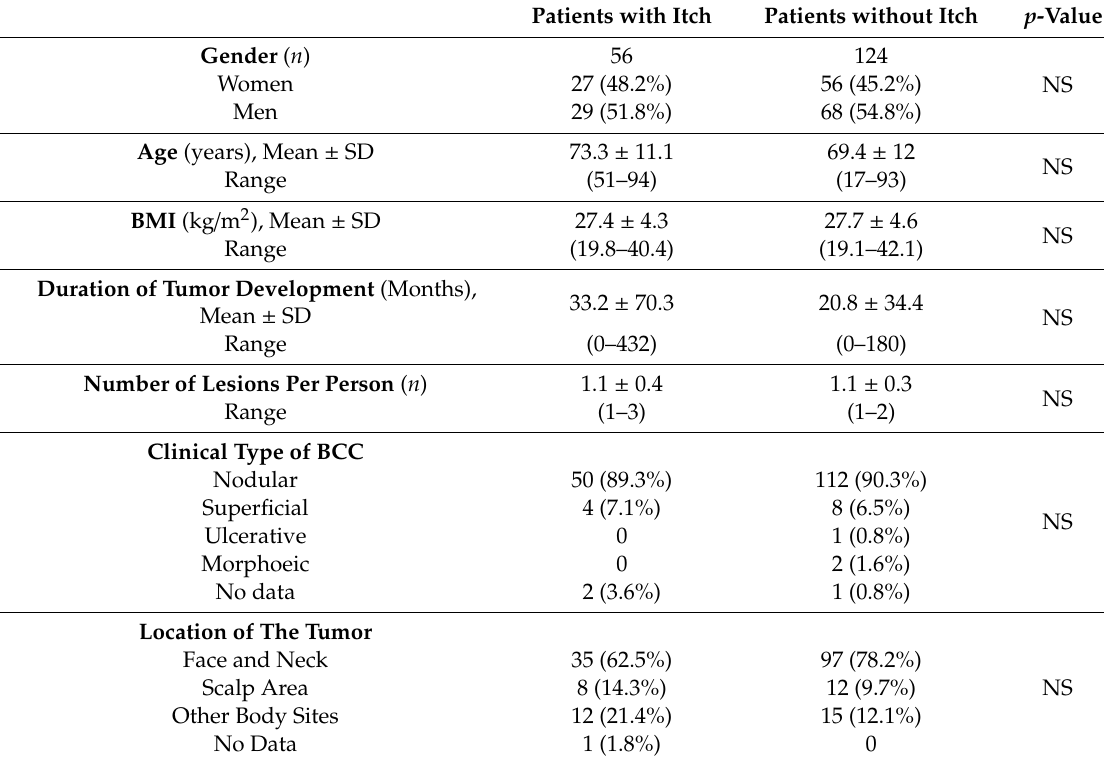
Table 1. Basic demographics and tumor-related data for itchy and non-itchy patients. Patients with Itch Patients without